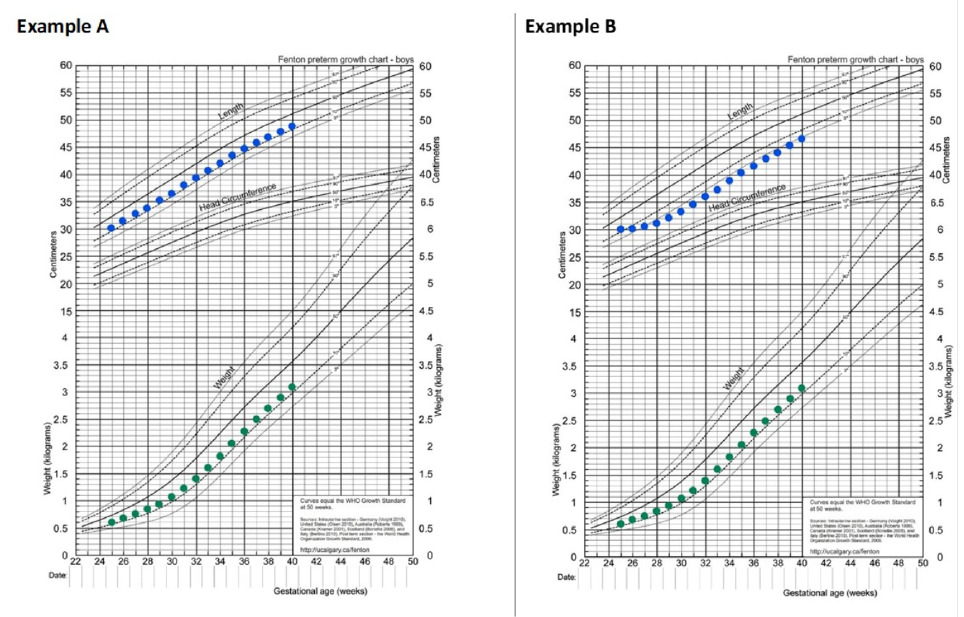
Figure 4. Comparison of adequate (Example A ) vs. early growth failure (Example B ) for linear growth in an extremely low birth weight infant from 25–40 weeks gestation with adequate weight gain. Examples A and B 2013 Fenton growth charts constructed and reprinted from the Pedi- Tools.org website [89,91,92] as available via open access and under terms of the Creative Commons Attribution